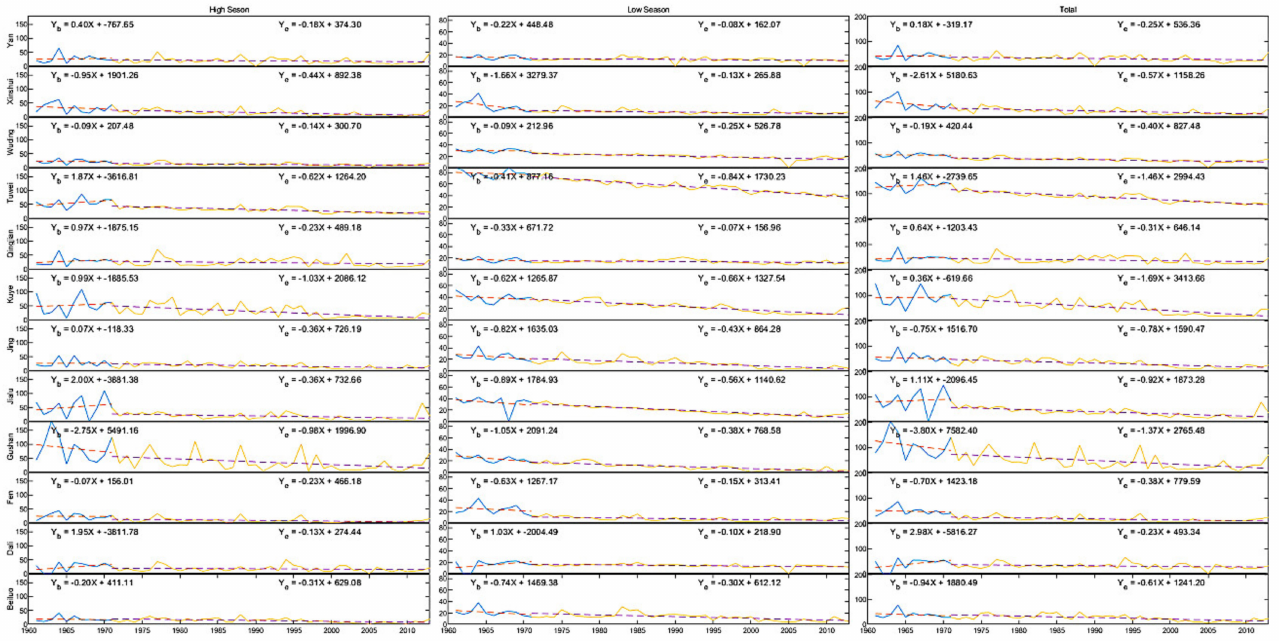
Figure A1. Time series of streamflow change for 12 catchments at intra- and inter-annual